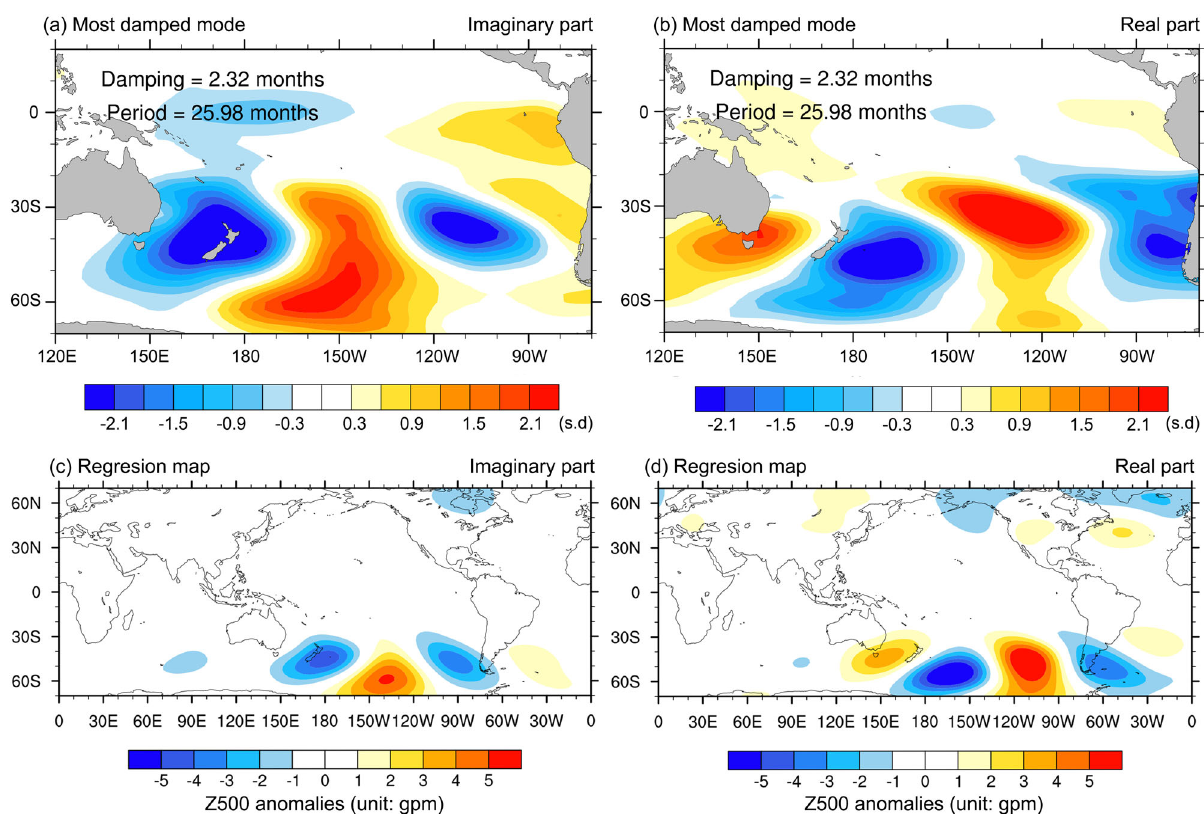
Fig. 2 The fastest damped SST modes. The imaginary ( a ) and real ( b ) parts of the fastest damped SST modes are obtained using a reduced-order linear inverse model (see the text for details). The pair of SST modes shown has the fastest damping time scale of 2.3 months. The maps are obtained by regressing the monthly Z500 anomalies (NCEP-NCAR) onto the time series of the imaginary ( c ) and real ( d ) parts of the fastest damped